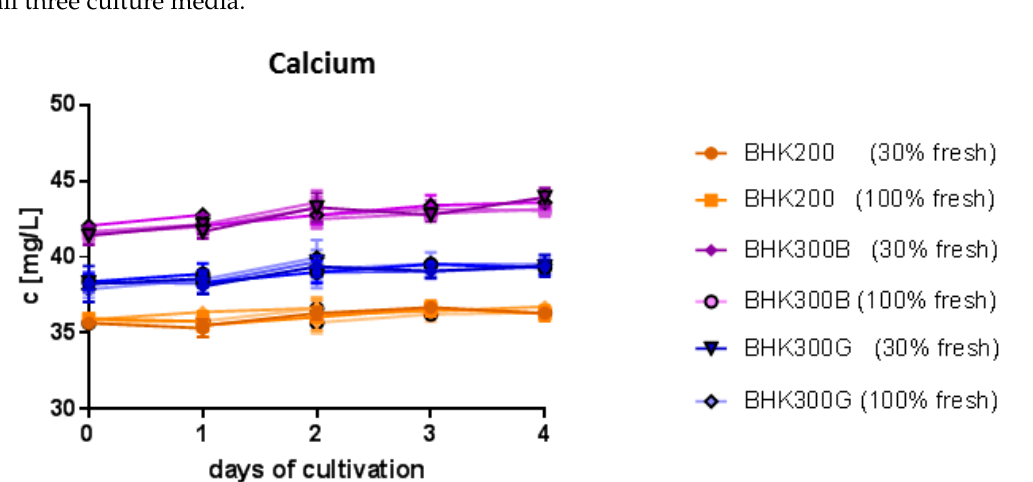
Figure 6. Calcium consumption of cells during batch analysis. Cells were grown in BHK200 (orange), BHK300B (violet) or BHK300G (blue) with either 100% medium supplementation or addition of 30% fresh medium.